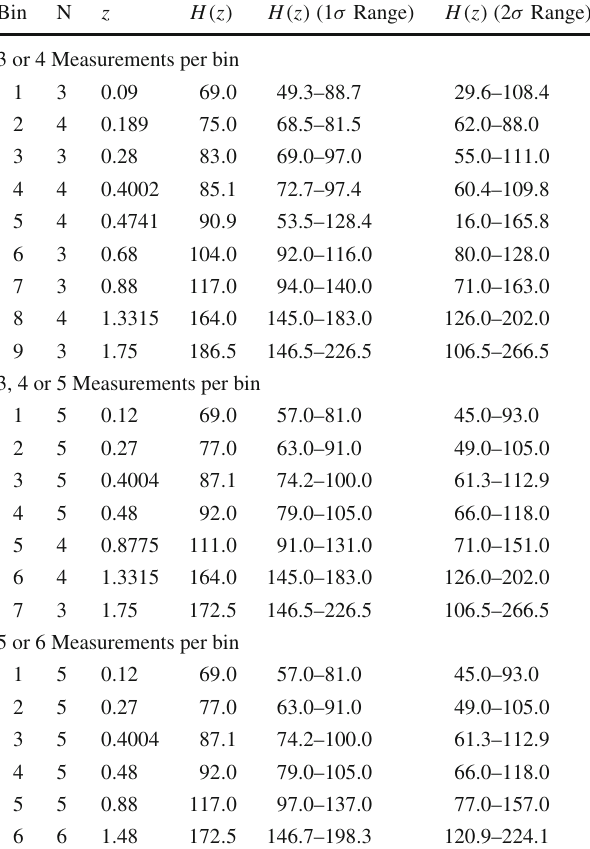
Table 5 Median statistics results for cosmic chronometer measure- ments, where the unit of H ( z ) is km s − 1 Mpc − 1